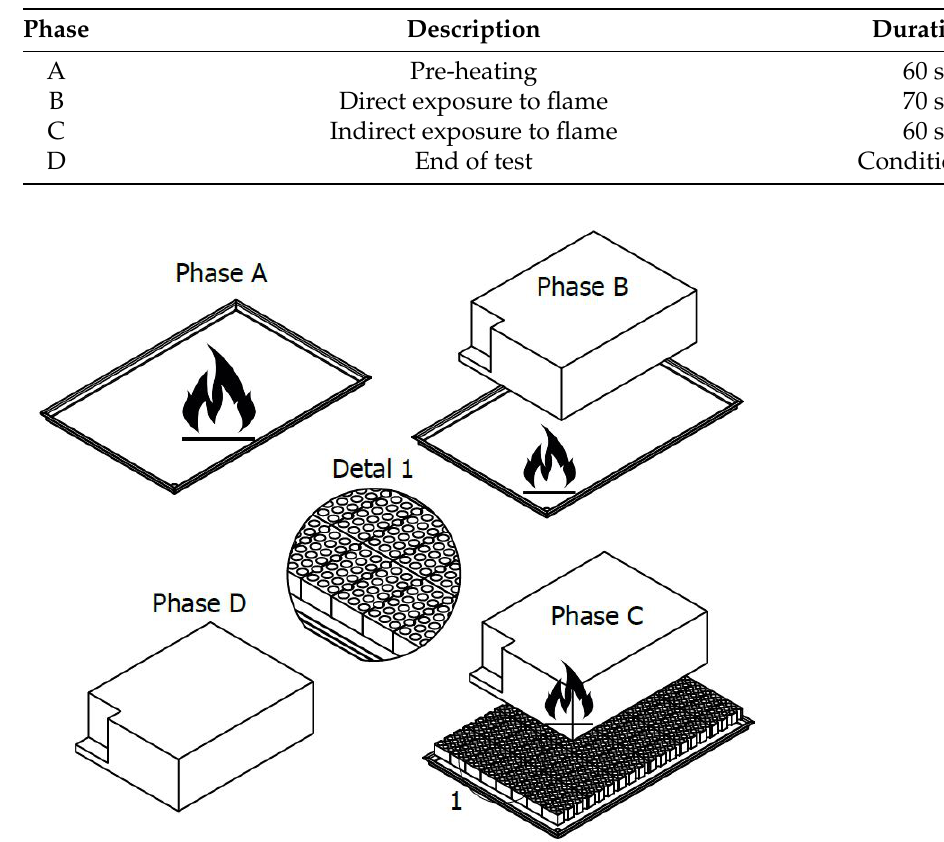
Table 2. Fire resistance test phases.